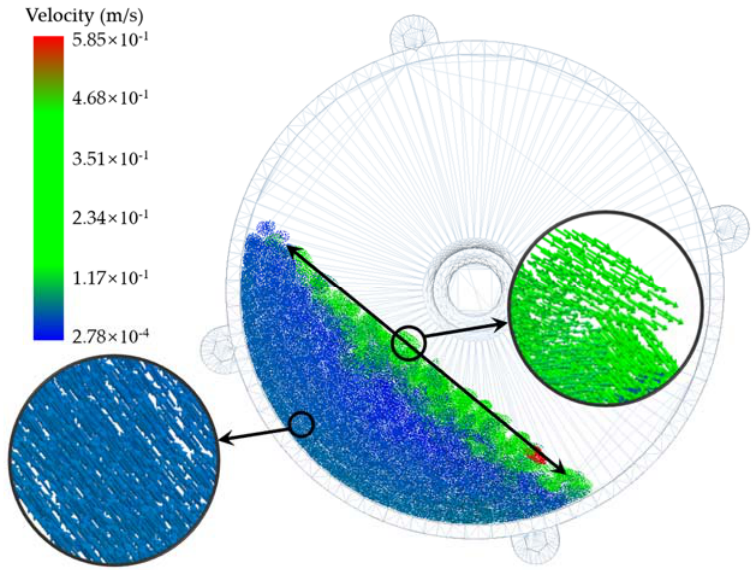
Figure 14. Velocity vector diagram of the cotton seeds in the rotating drum simulation test.